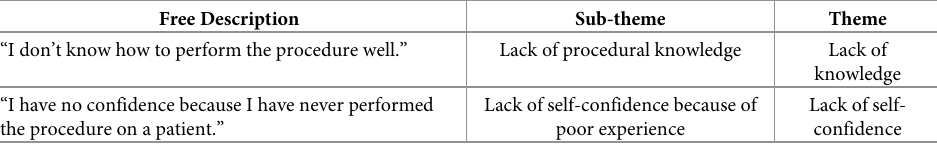
Table 2. Content analysis of pre-practice questionnaire (n = 83).